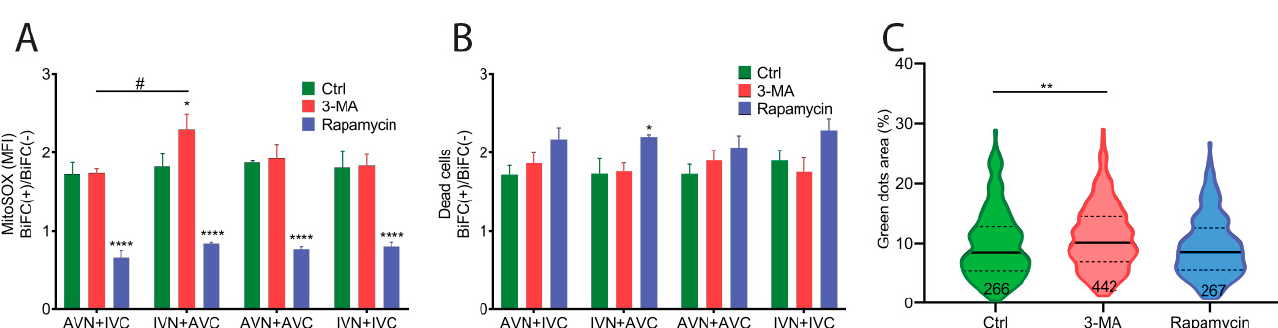
Figure 5. Expression of A β , IAPP, and A β + IAPP led to a higher superoxide production and induced cell death. ( A ) The ratio of mitochondrial superoxide production detected by the mean fluorescence intensity (MFI) of mitoSOX in BiFC(+)/BiFC( − ) cells of AVN + IVC, IVN + AVC, AVN + AVC and IVN + IVC-transfected cells in the control group, 3-MA-treated group, and rapamycin-treated group. ( B ) The ratio of PI-positive dead cells in BiFC(+)/BiFC( − ) cells of AVN + IVC, IVN + AVC, AVN + AVC, and IVN + IVC-transfected cells in the control group, 3-MA-treated group, and rapamycin-treated group. ( C ) Violin plot shows the fluorescent dots area (%) in AVN + AVC-transfected cells at 48 h post-transfection. Cells were treated with 3-MA or rapamycin at 6 h and 24 h post-transfection. ( A , B ) The results were analyzed by two-way ANOVA with Bonferroni’s multiple comparison test and presented as the mean ± SEM; * p < 0.05, **** p < 0.0001, and # p < 0.05, n = 3. ( C ), The results were analyzed by one-way ANOVA with Dunnett’s multiple comparison test; ** p < 0.01.